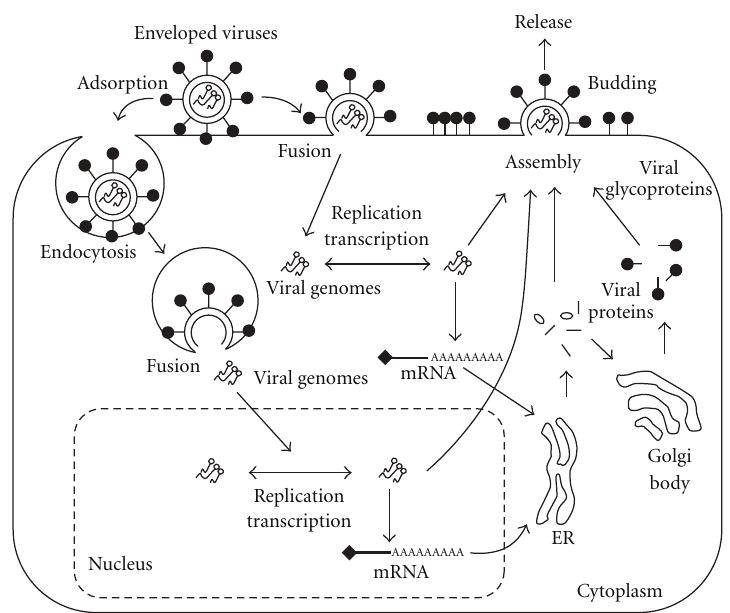
Figure 1: Entry, assembly, and budding processes of enveloped viruses. Some enveloped viruses, such as Orthomyxoviridae, Rhabdoviridae, and Togaviridae family viruses, are incorporated into cells through an endocytic pathway. Other enveloped viruses, such as Paramyxoviridae family viruses, are incorporated into cells through direct fusion between the viral membrane and cell surface membrane. Herpesviridae family viruses utilize both pathways. Viral genomes of enveloped RNA viruses, such as Orthomyxoviridae family viruses, and enveloped DNA viruses, such as Herpesviridae family viruses, are replicated and transcribed in the nucleus. On the other hand, viral genomes of enveloped RNA viruses, such as Paramyxoviridae family viruses, are replicated and transcribed in the cytoplasm. After assembly of viral proteins and genomes, progeny viruses are budded and then released from the cell surface membrane.